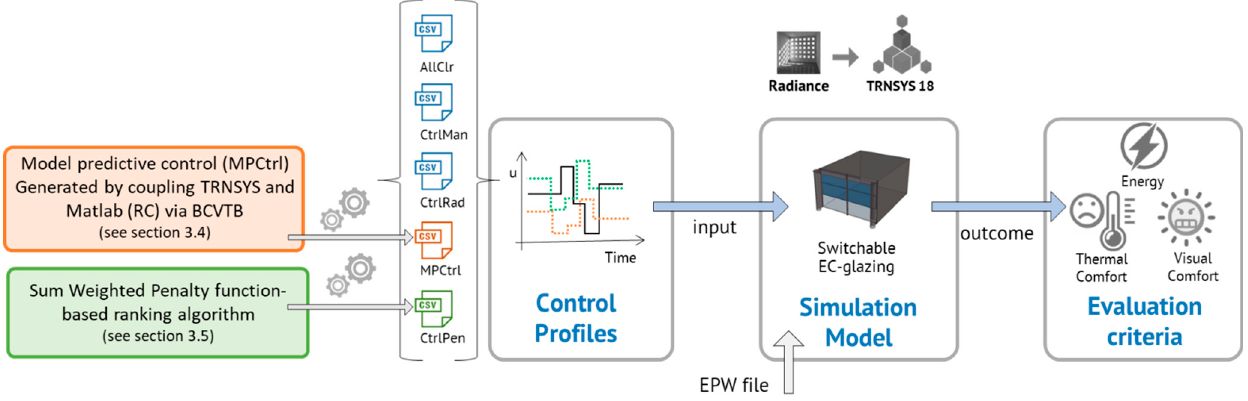
Figure 3. Simulation framework for evaluating different control